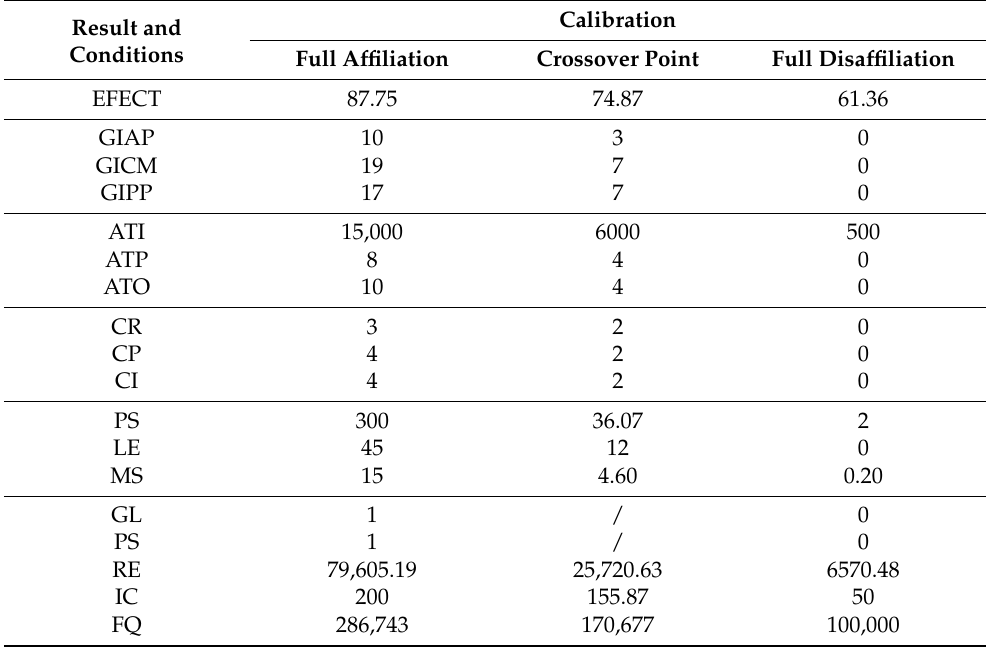
Table 1. Calibration of result to